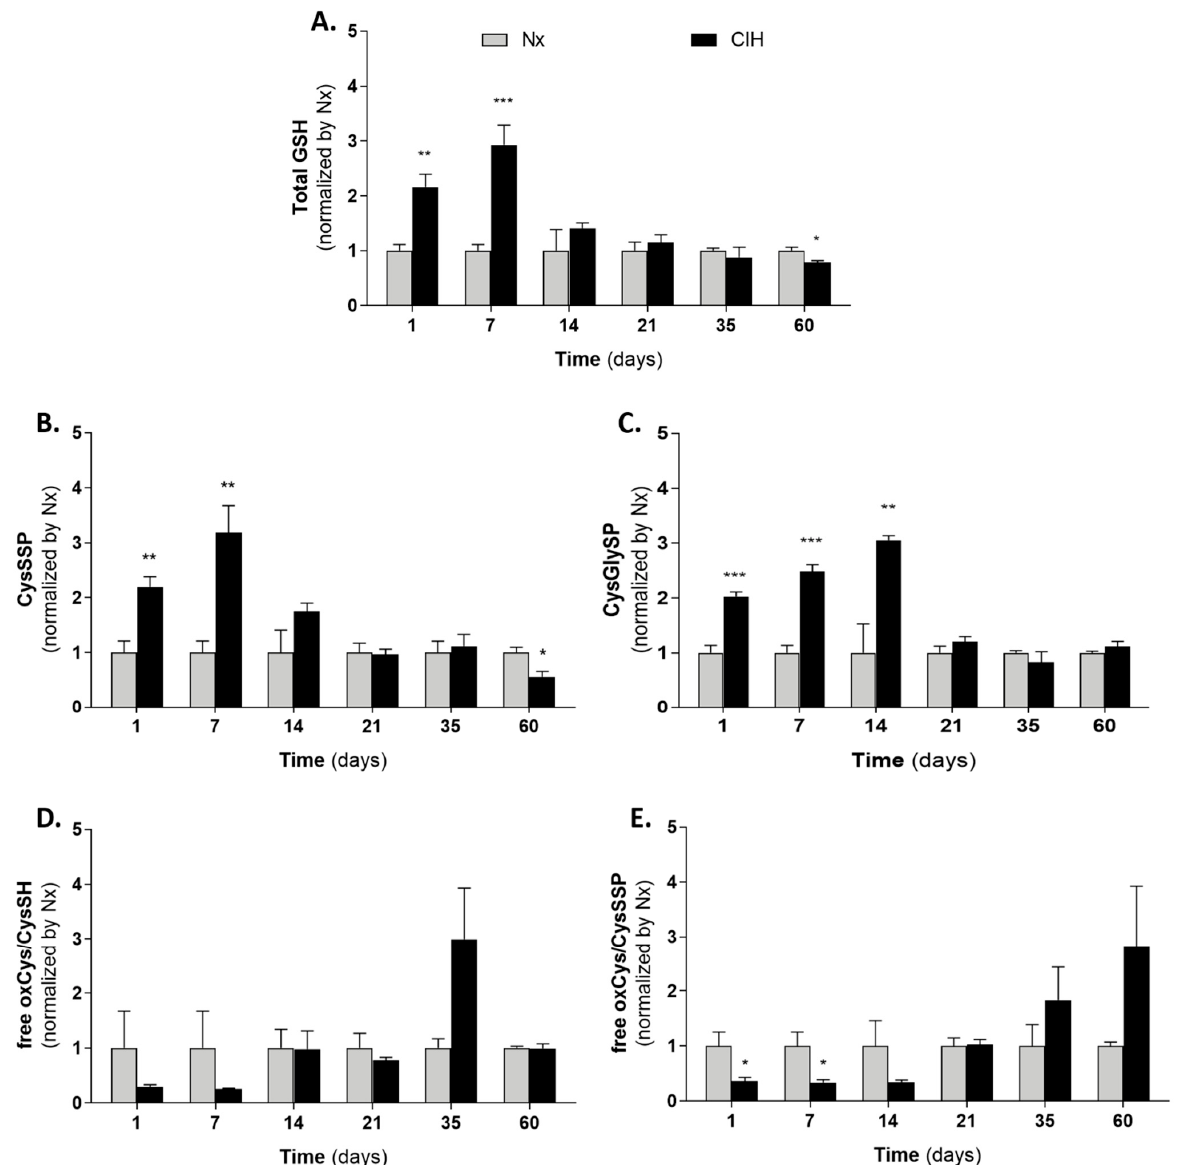
Figure 6. Impact of IH chronicity cysteine related thiolome in kidney cortex. ( A ) Total glutathione; ( B ) Cysteinylated proteins; ( C ) Cysteinylglycinylated proteins; ( D ) free oxidized Cys to reduced Cys ratio; ( E ) free oxidized Cys to Cysteinylated proteins ratio. Nx7D was used as control for CIH1D and CIH7D. Number of animals per group: Day of study ( n for Nx; n for CIH): D1 (5;5), D7 (5; 5) D14 (5; 6) D21 (11; 6), D35 (6; 8) and D60 (6; 6). Multiple t -test; comparison Nx vs. CIH: * p < 0.05; ** p < 0.01; *** p < 0.001. CIH: chronic intermittent hypoxia; Cys: cysteine; CysGly: cysteinylglycine; CysGlySP: cysteinylglycinylated proteins; CysSH: reduced cysteine; CysSSP: cysteinylated proteins; GSH: glutathione; Nx: normoxia; oxCys: oxidized cysteine.